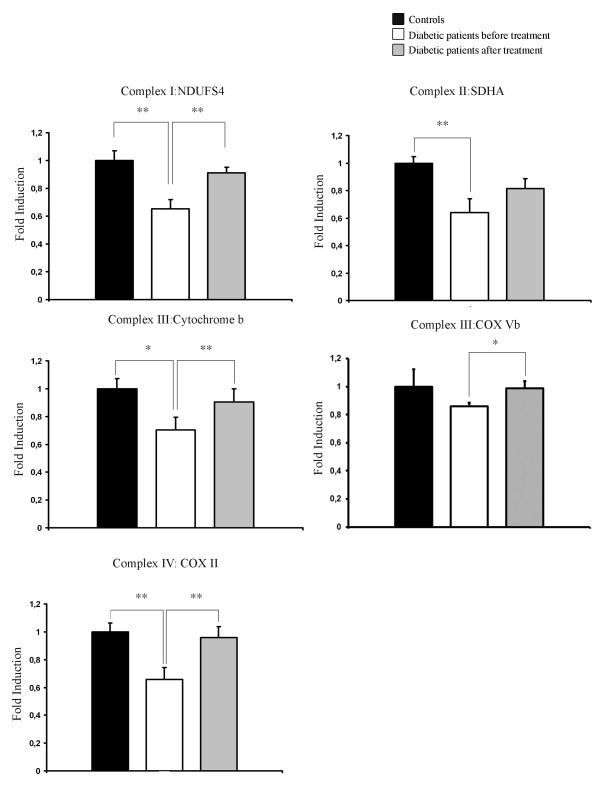
mRNA levels of genes coding for subunits in the electron transport chain. Relative expression levels of genes coding for subunits of the electron transport chain in healthy controls and diabetic patients before and after treatment with rosiglitazone for 90 days. (a) NDUFS4 in complex I, (b) SDHA in complex II, (c) cytochrome b in complex III, (d) COX Vb in complex III, (e) COX II in complex IV. Bars represents mean and error bars SEM. * = p < 0.05, ** = p < 0.01.